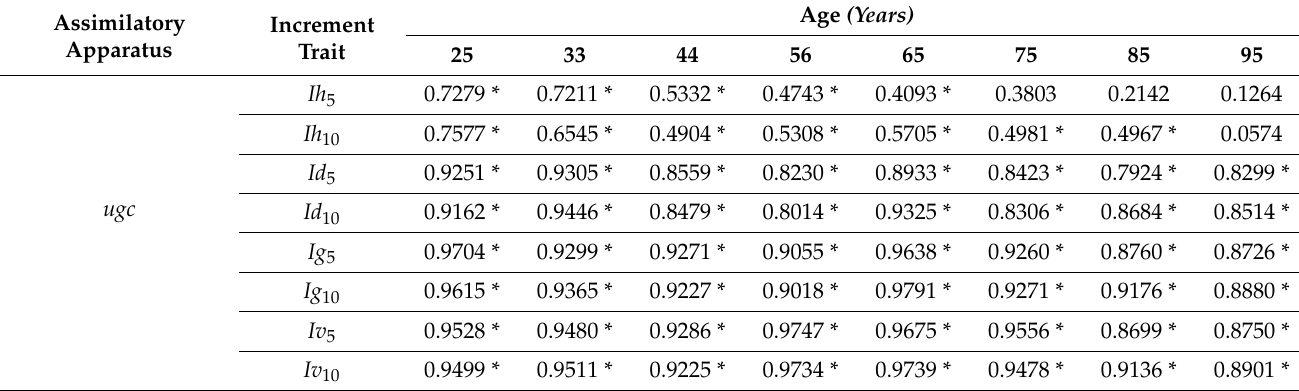
Table 7. Values of linear correlation coefficients r between the weight of leaved twigs ( ugc ) and increment traits ( Ih 5 , Ih 10 , Id 5 , Id 10 , Ig 5 , Ig 10 , Iv 5 , Iv 10 ) depending on the age of the stands.